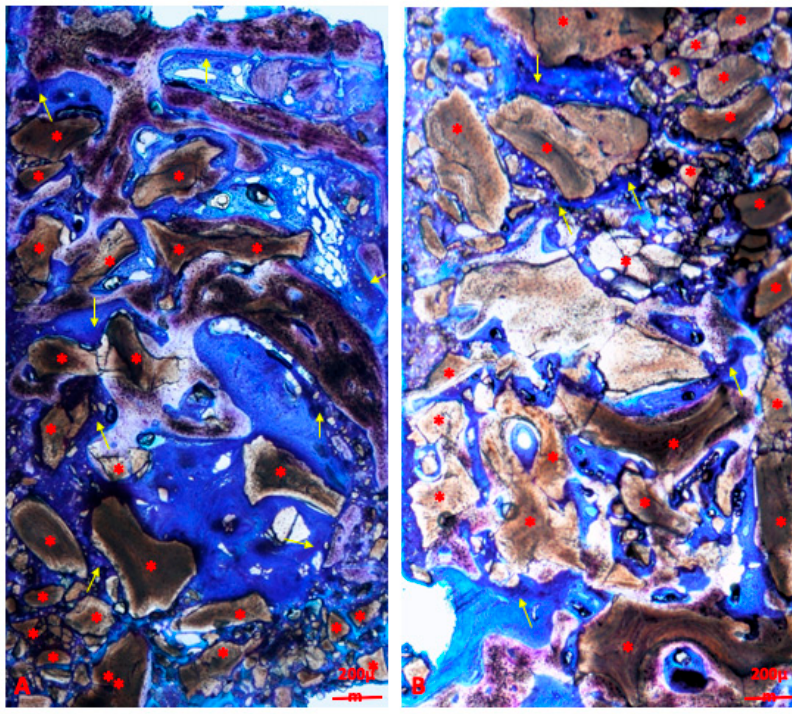
Figure 3. Overview of samples of the mineralized deproteinized bovine bone (DBMM) group (bar scale = 200 microns). Red asterisks are placed on blocks of biomaterials and yellow arrows indicate osteoid matrix. Blocks are surrounded by newly formed lamellar bone at different phases of mineralization. Blocks are easily recognizable and differentiable by bone that appears stained in shades of light brown and violet. ( A ) and ( B ) present differences in biomaterial amount, more represented in ( A ) than in ( B ), and consequent quantity of newly formed bone. Toluidine blue and pyronine yellow staining.